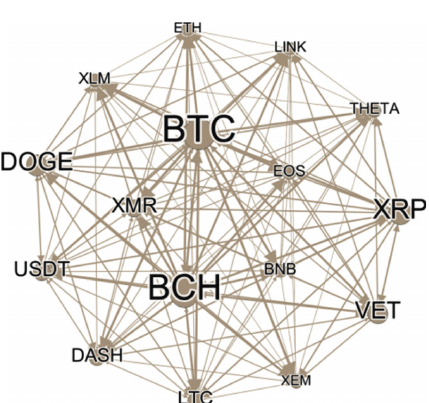
Figure 42: Risk spillover under